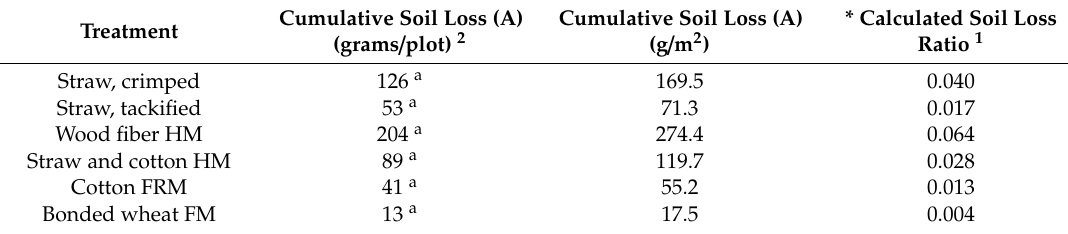
Table 6. Cumulative soil loss for four, 15-min rainfall events (A) and calculated soil loss ratio per